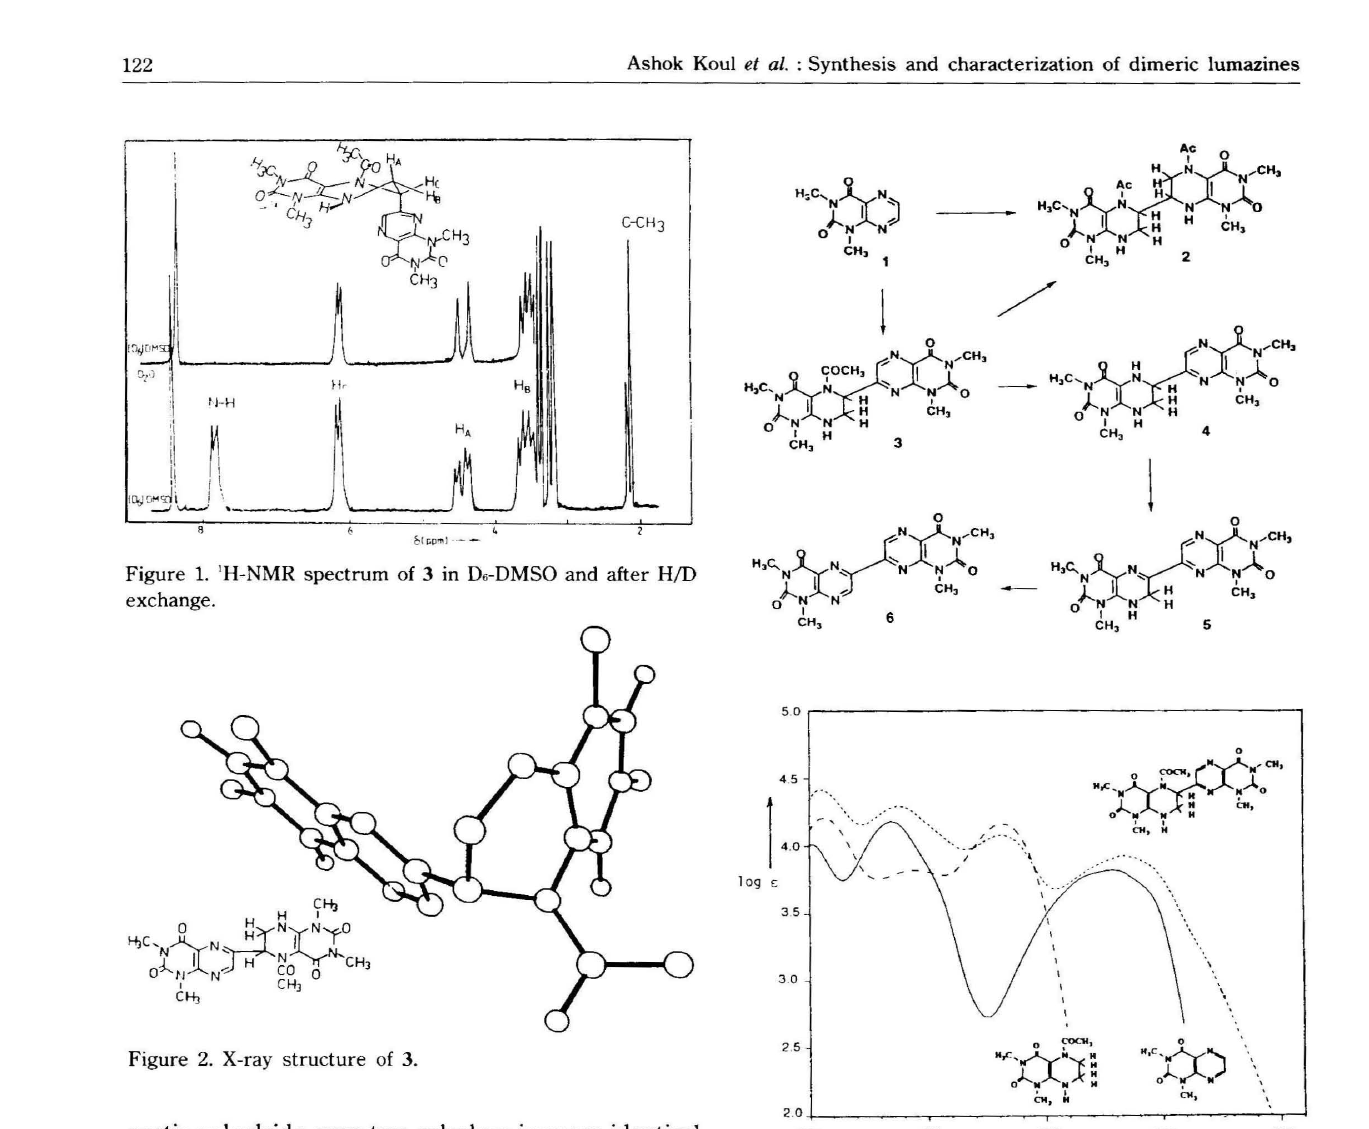
Figure 2. X-ray structure of 3.